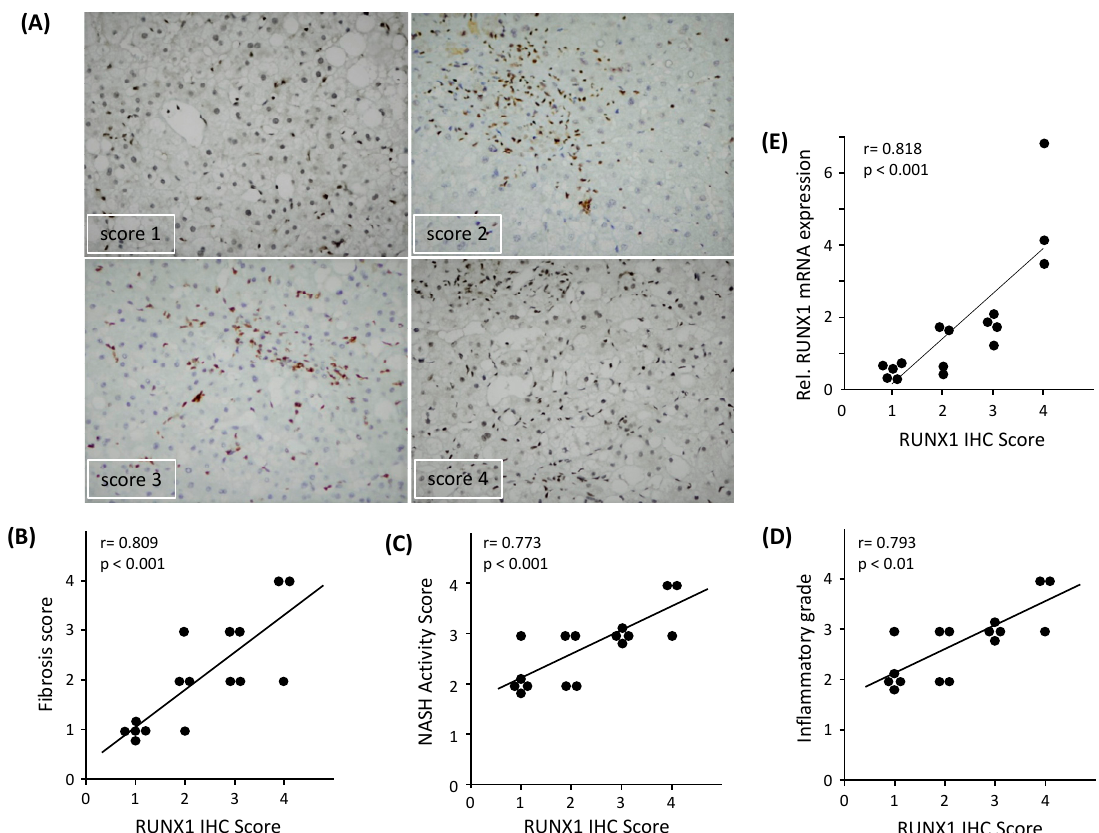
Figure 2. Immunohistochemical (IHC) analysis of RUNX1 expression in NASH patients. ( A ) RUNX1 immunostained images (20 × objective) with an increasing number of brown nuclear immuno-positive cells (score 1–4). RUNX1 positivity was mostly observed in the non-parenchymal cells. Hematoxylin stained nuclei were distinguishable from RUNX1-positive brown nuclei. ( B ) Correlation between RUNX1 IHC and NASH activity score ( n = 16), ( C ) RUNX1 IHC score and fibrosis grade ( n = 16), and ( D ) RUNX1 IHC score and inflammatory grade ( n = 16) in NASH patients. ( E ) Correlation between RUNX1 mRNA and its IHC score in liver tissues of patients (n = 16). The Pearson correlation (r) and statistical significance ( p ) were calculated.